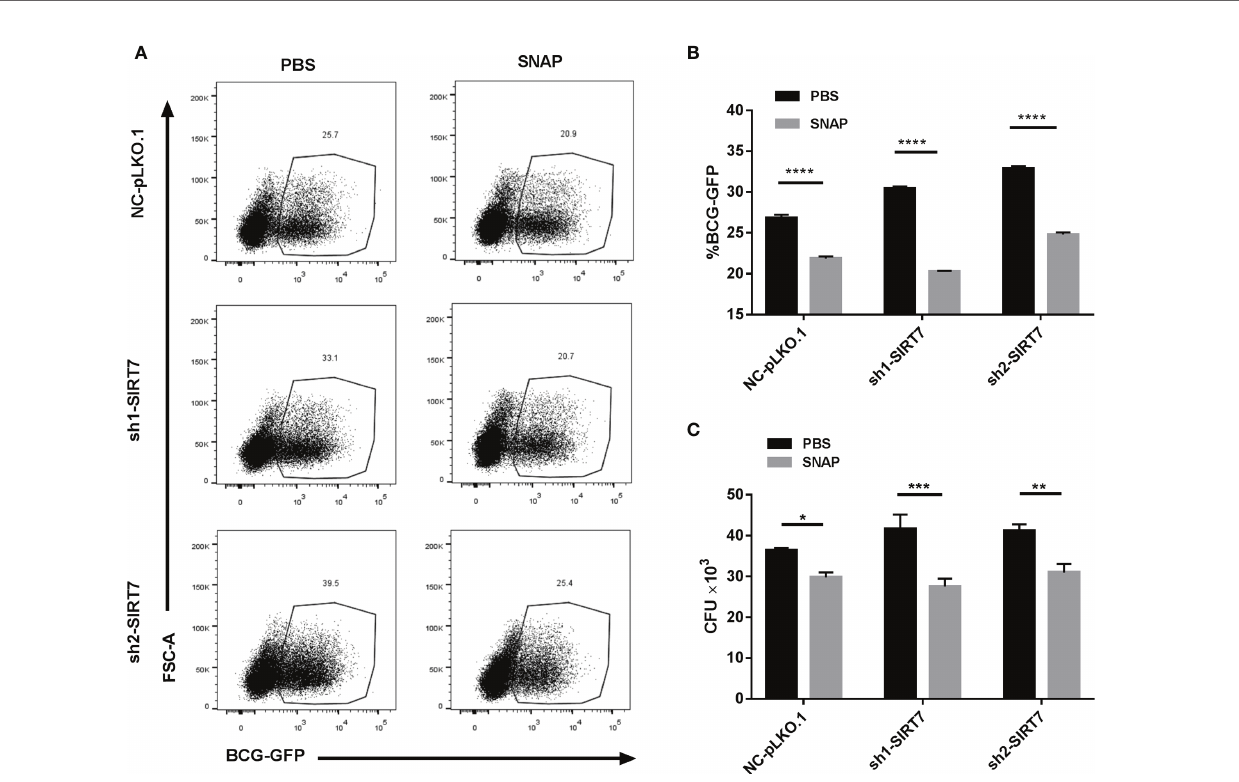
FIGURE 6 | Nitric oxide donor SNAP abrogates the SIRT7-knockdown-induced increase in Mycobacteria burden in Raw264.7 cells. (A, B) SIRT7-knockdown Raw264.7 cells were pretreated with SNAP (200 m M) 24 h before infection with BCG-GFP (MOI 10:1) and were then analyzed by fl ow cytometry 24 h after infection. Representative fl ow cytometry images (A) were recorded and the percentage of BCG-GFP positive Raw264.7 cells (B) were calculated by Flow Jo software. (C) Colony-forming unit (CFU) counts of SIRT7-knockdown Raw264.7 cells treated with or without SNAP (200 m M) 48h after infection. Data represent means ± SD for three independent experiments. Two way ANOVA was performed in (B, C) . *p < 0.05; **p < 0.01; ***p < 0.001; ****p<